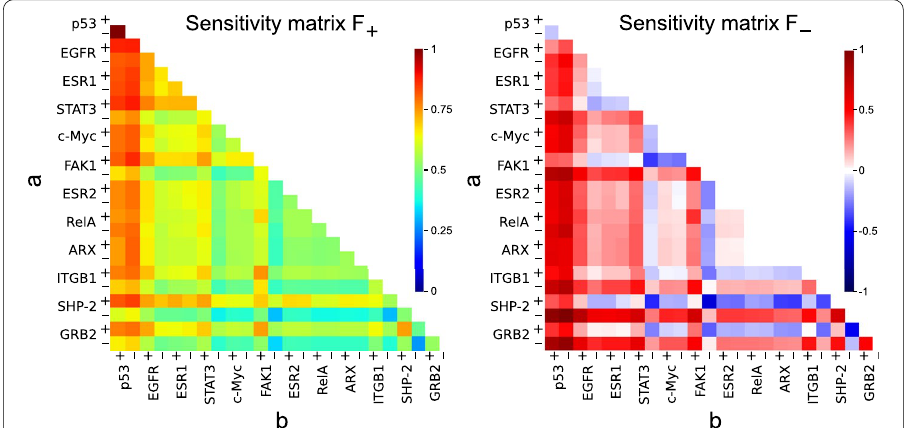
Fig. 7 PageRank sensitivity matrices F + ( a , b ) (left panel) and F − ( a , b ) (right panel) associated to the subset of nodes presented in Table 1 and belonging to the Ising MetaCore network. The values of the color bar correspond to F + ( a , b )/ max a , b ( F + ( a , b )) (left panel) and to F − ( a , b )/ max a , b | F − ( a , b ) | (right